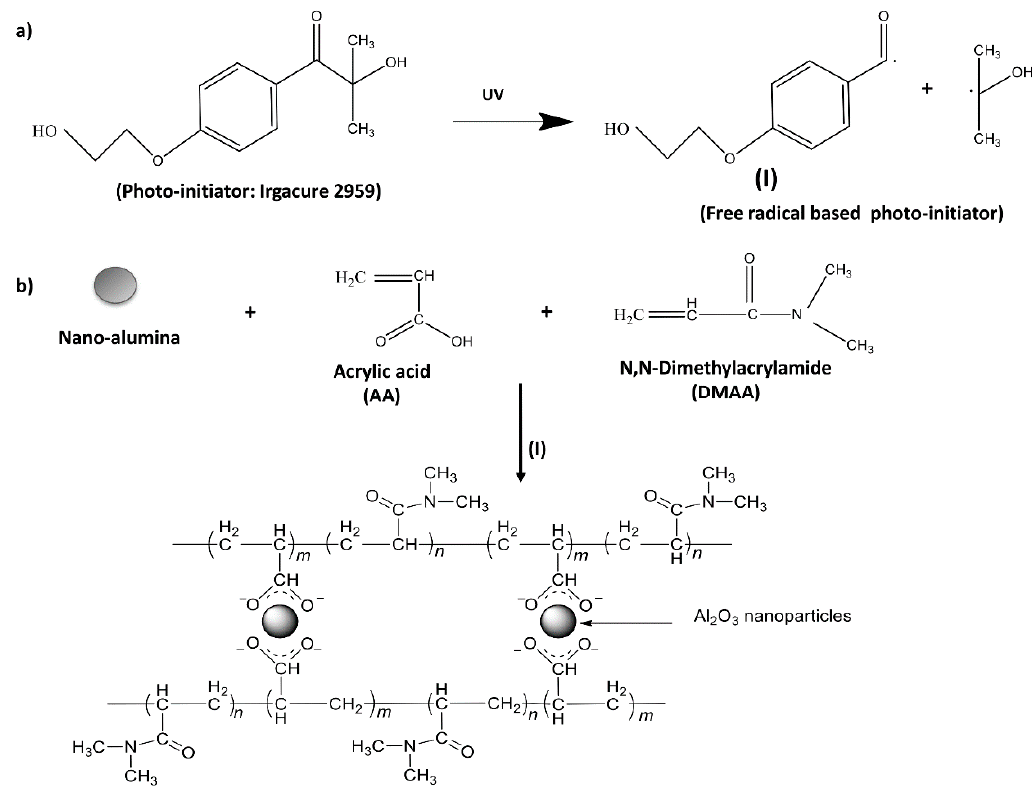
Figure 1. ( a ) Formation of the initiator radical; ( b ) Formation of the hydrogel with nano-alumina